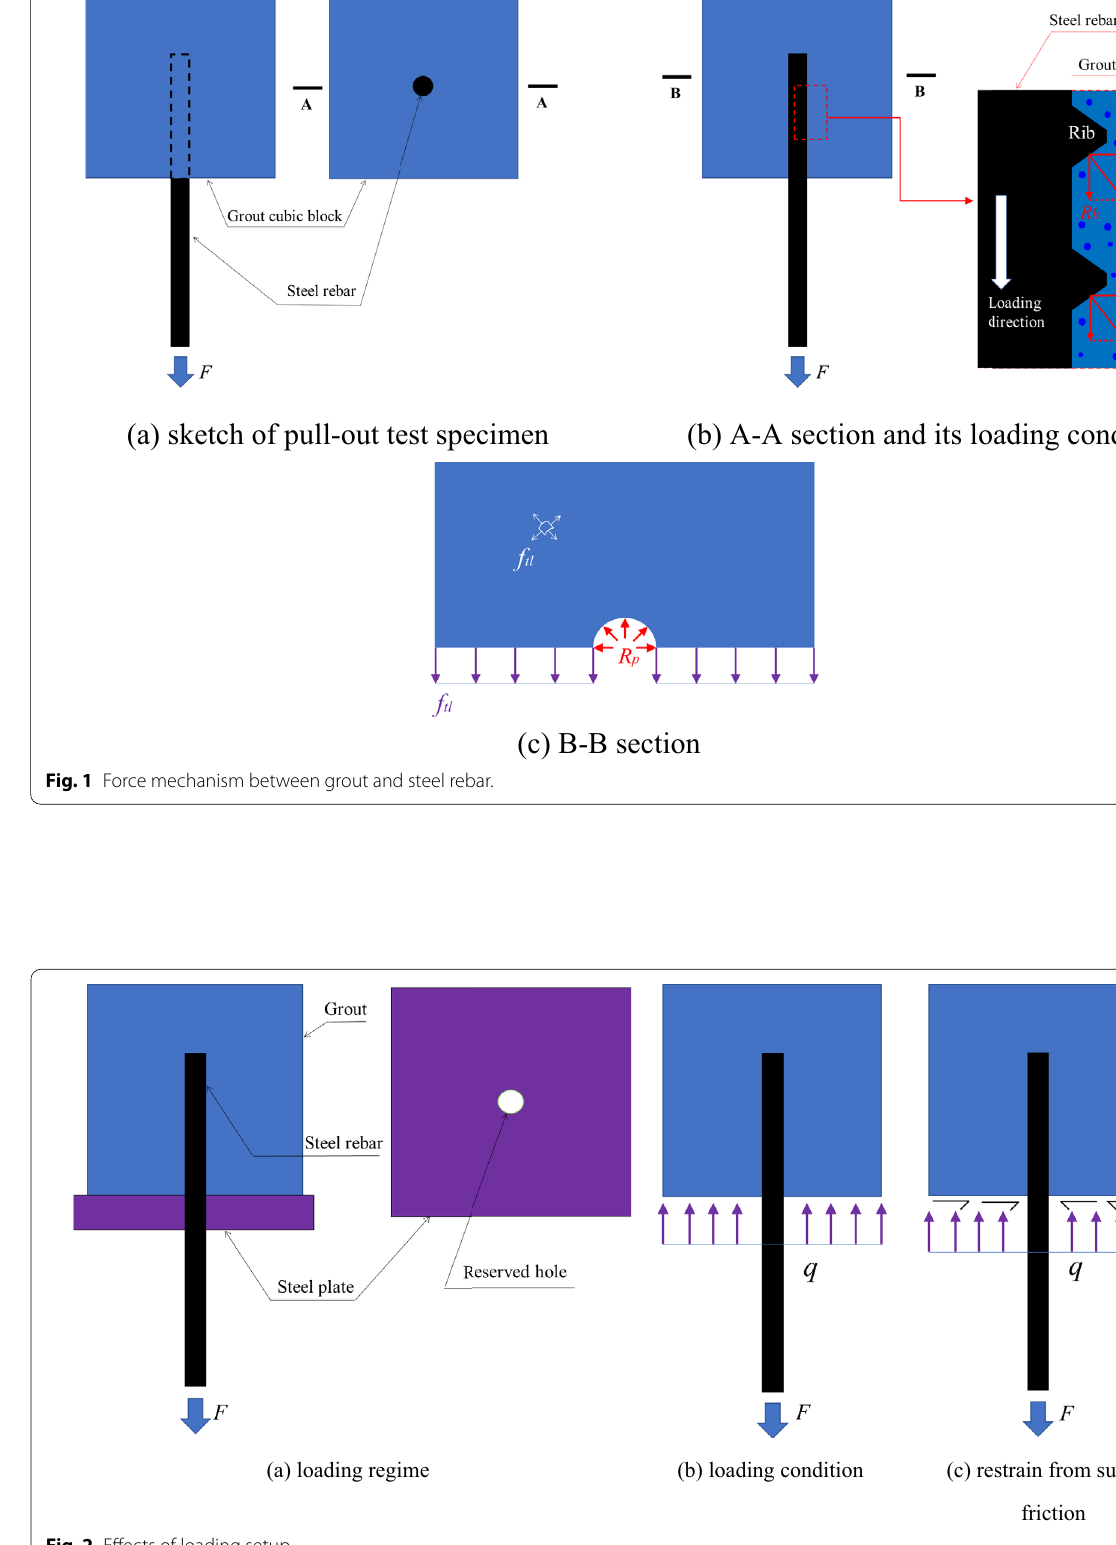
Fig. 2 Effects of loading